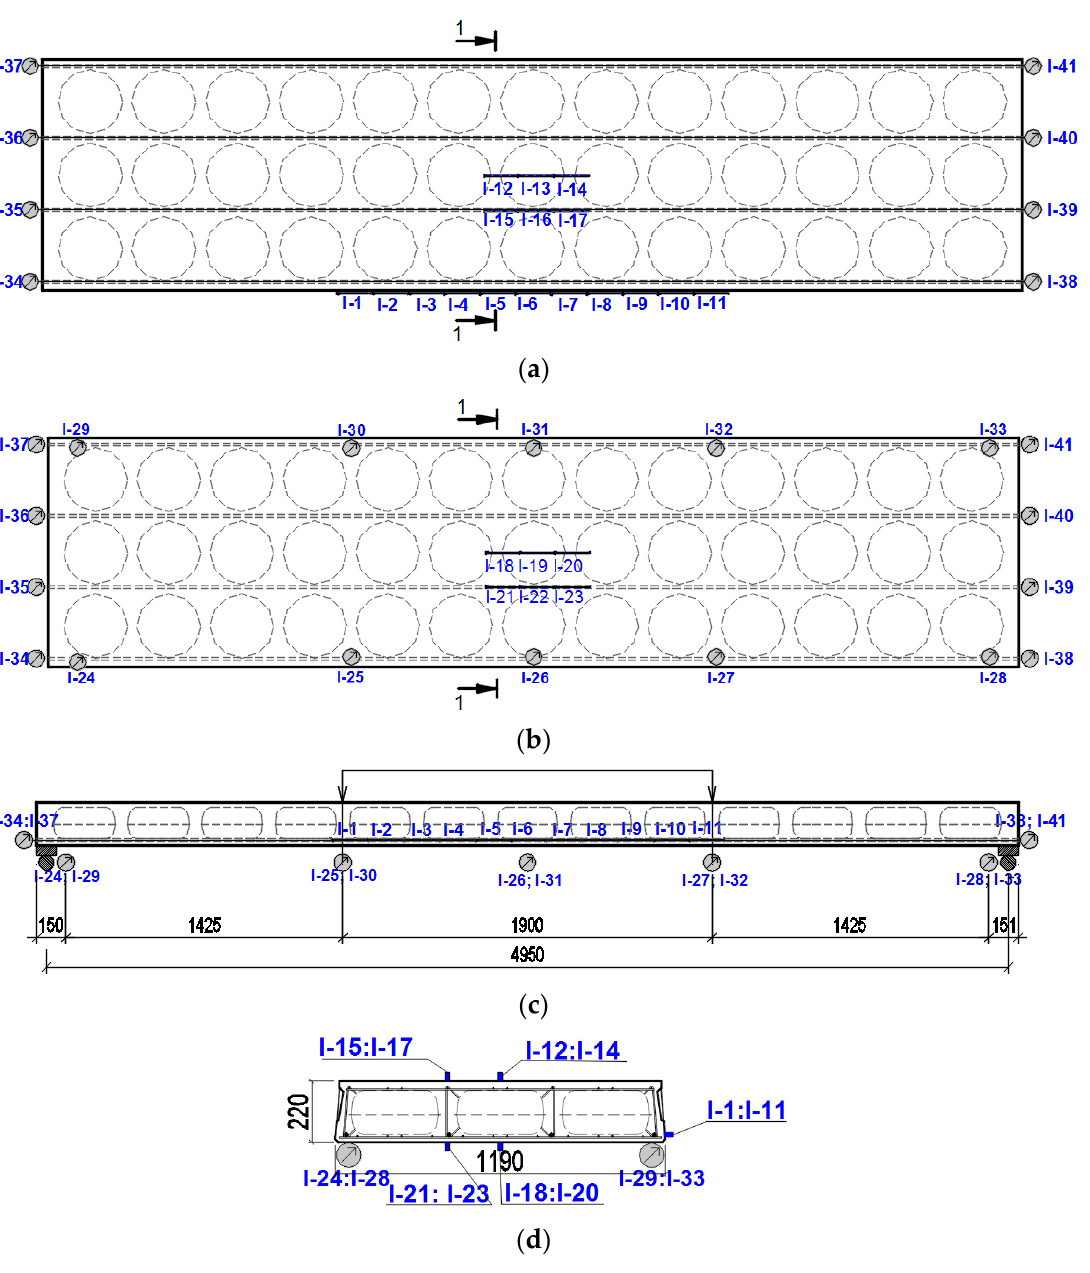
Figure 6. Slab test scheme with strain gauges. ( a ) The top of the slab; ( b ) the bottom of the slab; ( c ) side view of the slab; ( d ) slab section